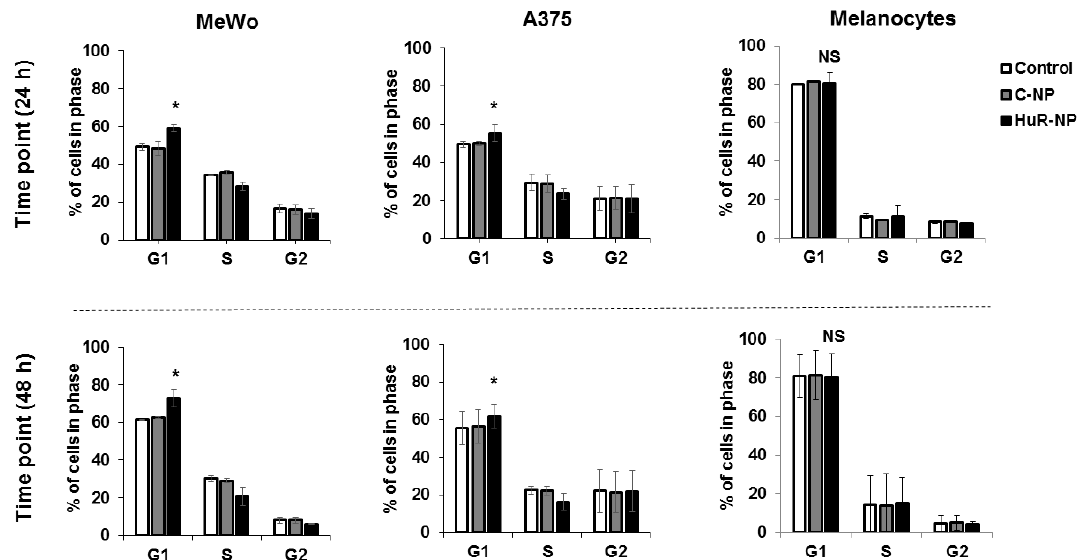
Figure 3. HuR-NP treatment induced G1 phase cell-cycle arrest in melanoma cell lines but not in melanocytes. Cell cycle analysis of melanoma cell lines (MeWo, A375) and melanocytes, at 24 h and 48 h after treatment with either C-NP or HuR-NP. Untreated cells served as control. Error bar denotes SD; NS not significant; * p < 0.05.